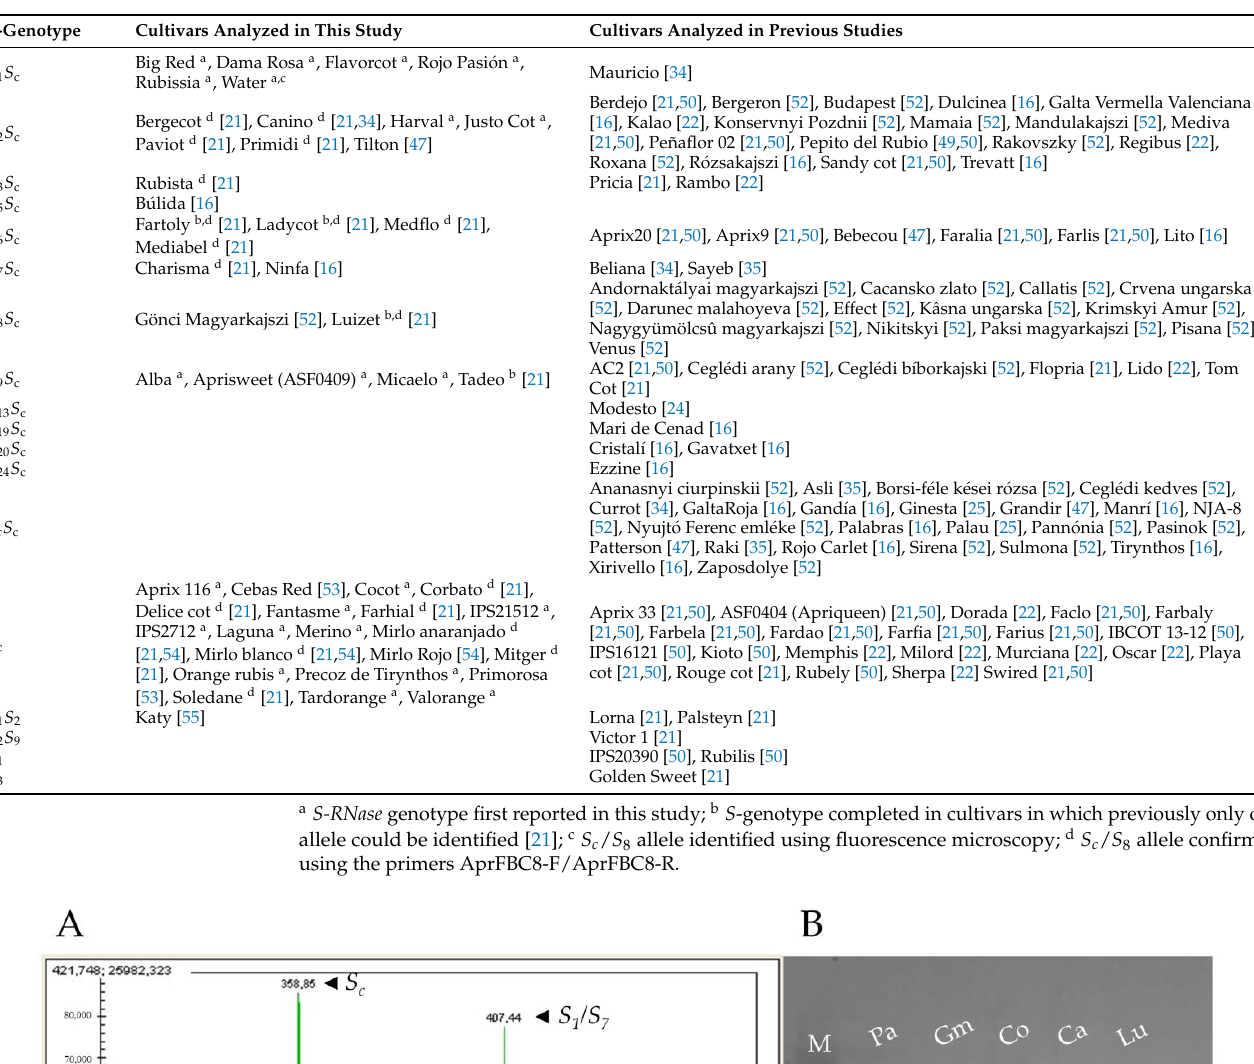
Table 2. S -genotype of 153 self-compatible apricot cultivars.